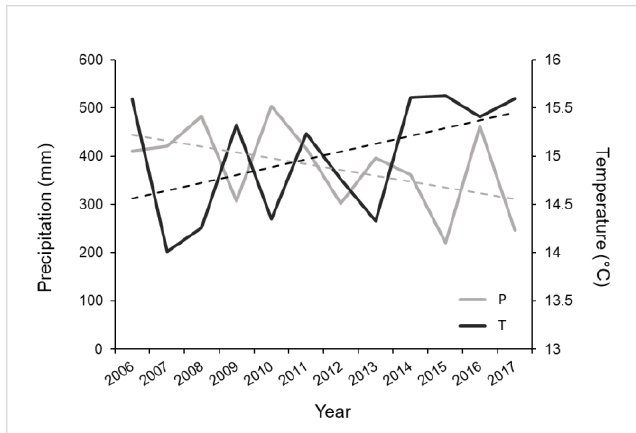
Figure 1. Annual precipitation (in continuous grey line) and average temperature (in continuous black line) for the 10 years previous to the experiment. Dashed lines show the tendency through time for both parameters.